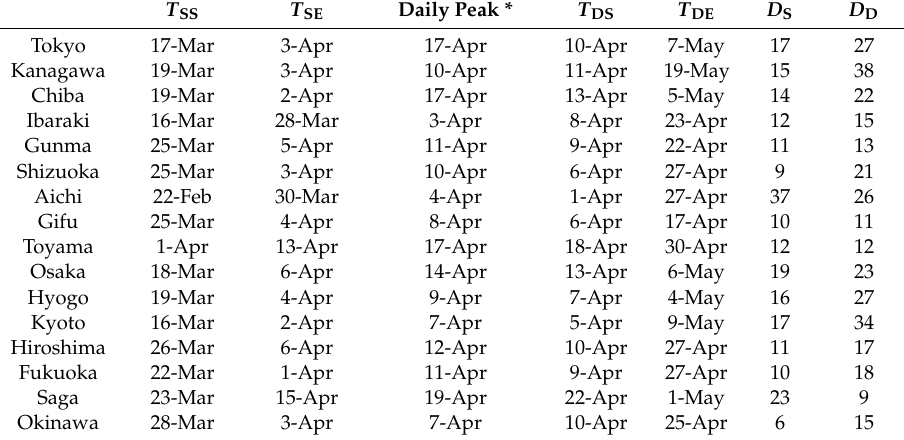
* Moving average is not applicable for daily peak values.